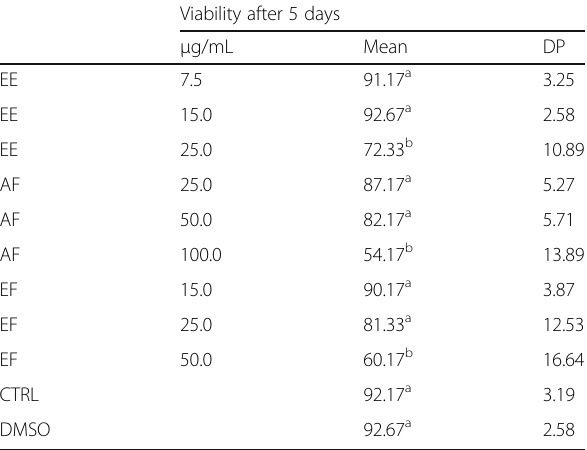
Table 2 Effect of EE extract and AF and EF fractions from stem bark of L . ochrophylla on cell viability after 5 days of